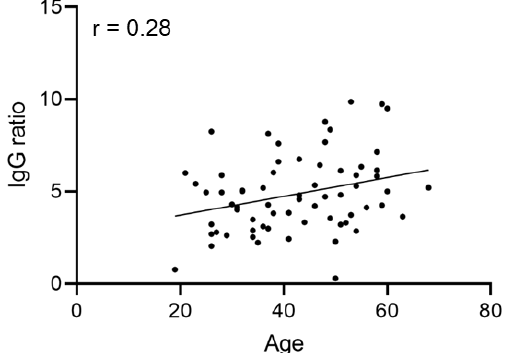
Figure 1. SARS-CoV-2 anti-S antibody levels of CP donors are declining over time. Data shown are anti-S IgG ratio values grouped as indicated for each plasma donation. Day 0 represents the first plasma donation, all further donations are depicted as time difference to the first donation, given in days.